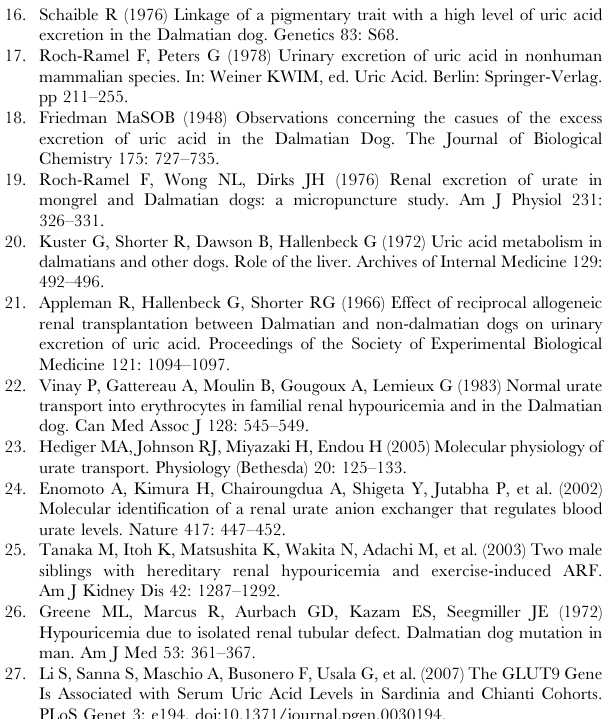
Table S3 Candidate gene primers. XLS) Figure S1 Numbers indicate that DNA was available; individual 3 is placed twice in the pedigree for clarity, individuals numbered 39 and higher were genotyped and phenotyped after Safra et al. (2006). Standard genetic symbols are used for sex and affectation status. The single male Pointer used in this pedigree is shown at the top; all other dogs were purebred Dalmatians or backcross